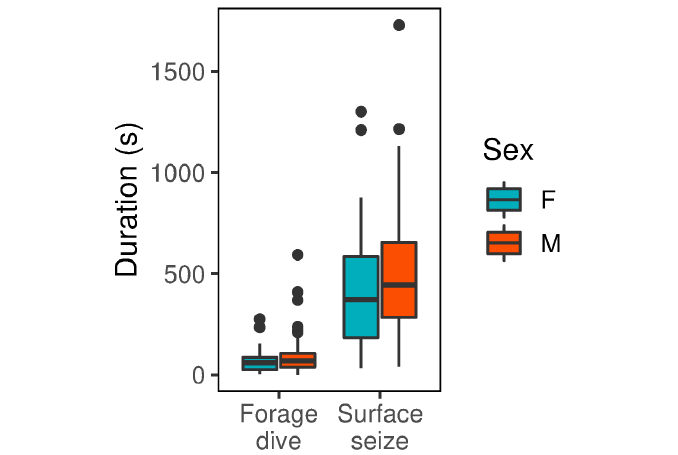
Fig 7. Daily foraging durations of males and females. Daily durations of diving (D) or surface seizing (S) between males and females. Males tended to forage for longer than females, however, this difference was not significant ( p > 0.05, linear mixed model with ID and trip number as mixed effects).